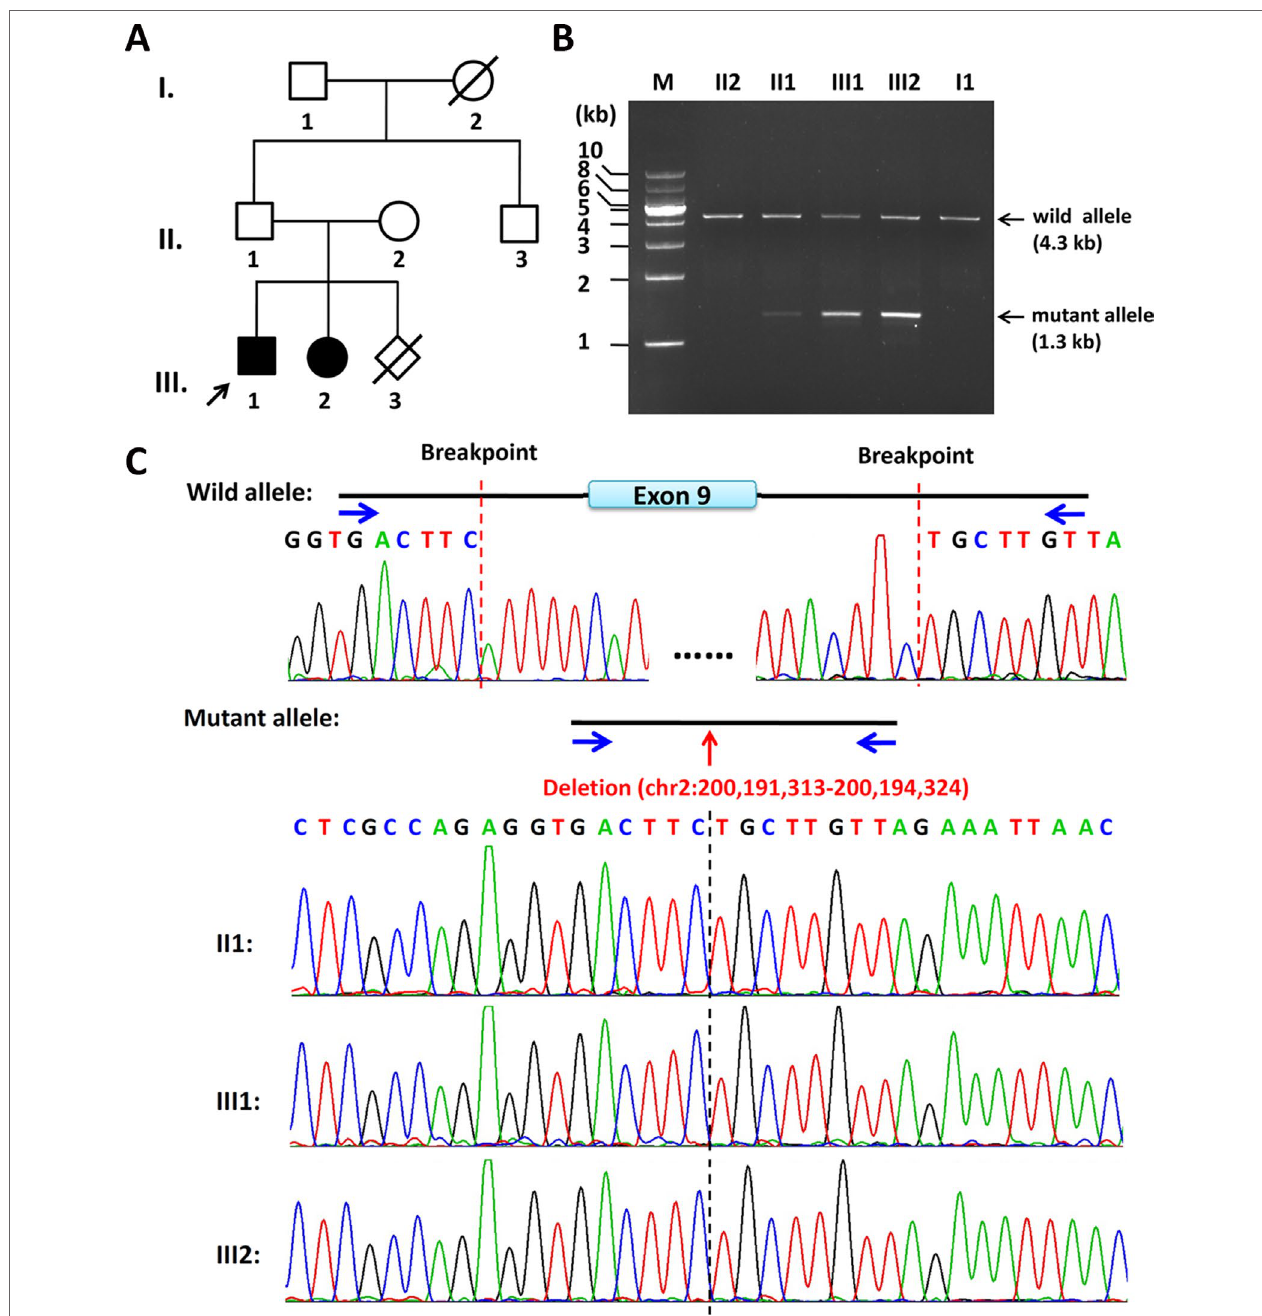
FIGURE 1 | Pedigree of the family and the characterization of the deletion breakpoints by gap-PCR. (A) Pedigree of this family. The arrow refers to the proband. The solid square (male) and circle (female) represent the two affected siblings; (B) Gap-PCR of family members using the peripheral blood-derived genomic DNA and primer sets (4334-F/R). Lanes 1–7: Marker, II2, II1, III1, III2, II3, and I1. The expected SATB2 wild allele band of ~4.3 kb is seen in members of II2, II1, III1, III2, II3, and I1. A lower band, consistent with the size of mutant allele, is seen in II1, III1, and III2 but not in II2 or I1. Notice that the father (II1) has a much less intense band of about 1.3 kb in size, which is the same size as his two children (III1 and III2). (C) Sequencing results of the ~4.3-kb band and 1.3-kb band. The intragenic deletion border is chr2: 200,191,313-200,194,324 (hg19), which includes the entire exon 9 and its franking intronic sequences of the SATB2 gene. Blue arrows refer to gap-PCR primer set (4334-F/R) used to detect the breakpoints of the 3kb